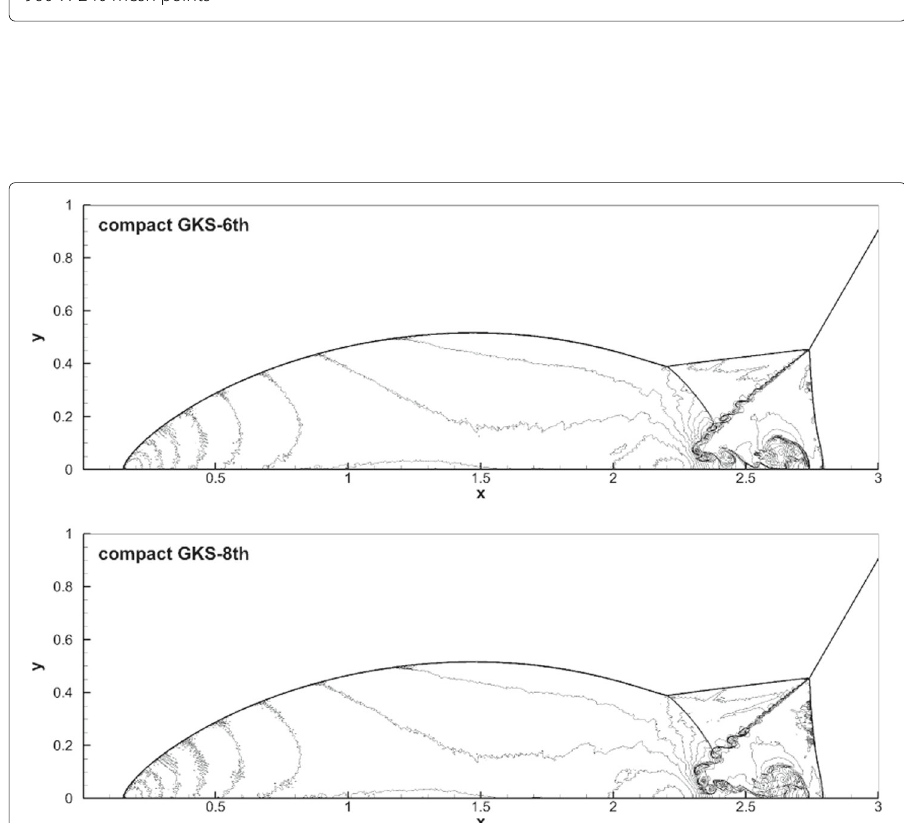
Fig. 13 Double Mach reflection: the density contours of 6th-order and 8th-order compact GKS with 1920 × 480 mesh